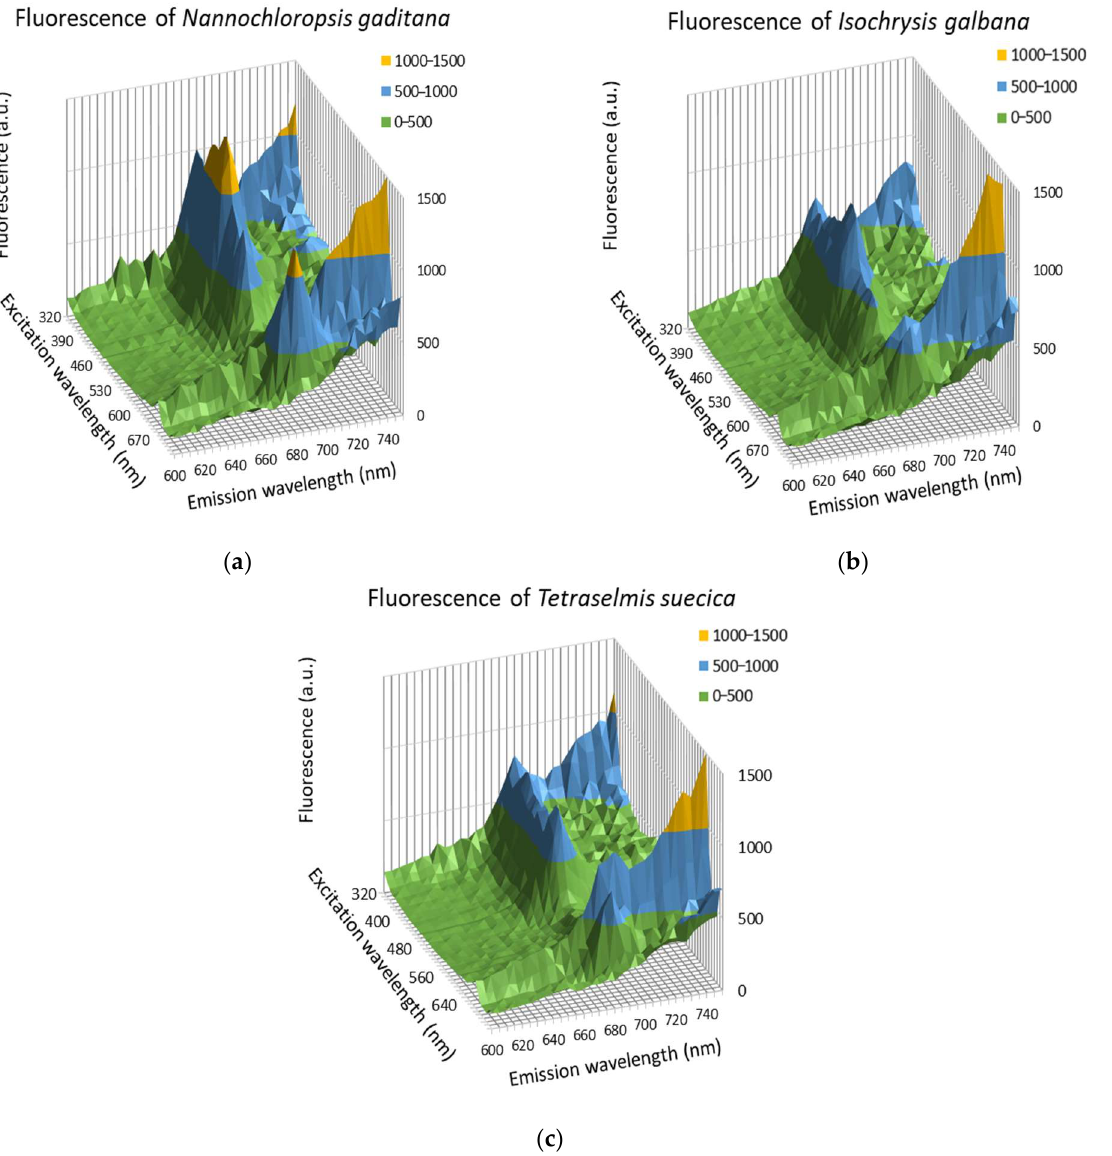
Figure 3. Fluorescence spectrum with excitation light scanned from 320 nm to 700 nm of ( a ) of Nannochloropsis gaditana , ( b ) Isochrysis galbana and ( c ) Tetraselmis suecica .